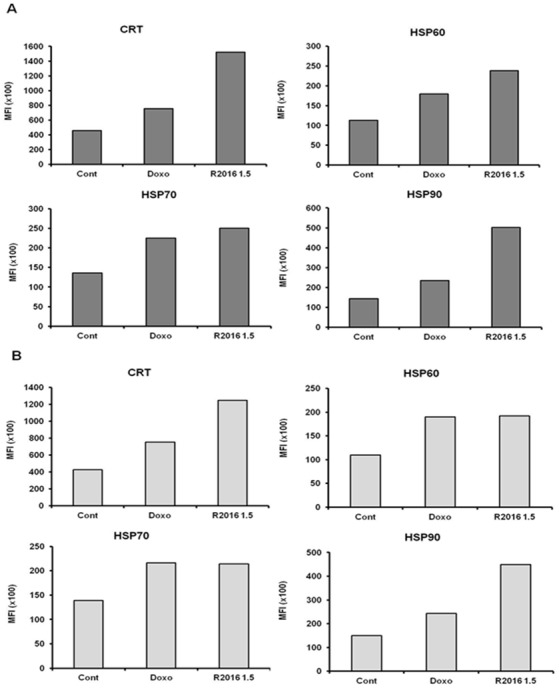
Expression of DAMPs (CRT, HSP60, HSP70, and HSP90) on the cell surface following R2016 treatment in LLC (A) and B16F10 (B). Representative histograms of three experiments show the increased expression of CRT, HSP60, HSP70, and HSP90 after R2016 treatment. The expression of the indicated markers is shown as mean fluorescence intensity (MFI).